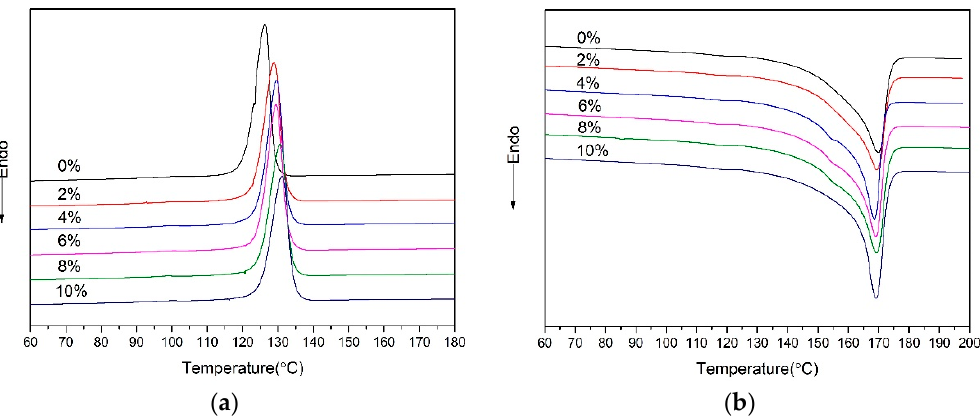
Figure 4. The differential scanning calorimeter (DSC) curves of nanocomposites: ( a ) crystallization curves; ( b ) melting curves. Table 1. Comparison of the fusion and crystallization properties of nanocomposites. Content of nano-CaCO 3